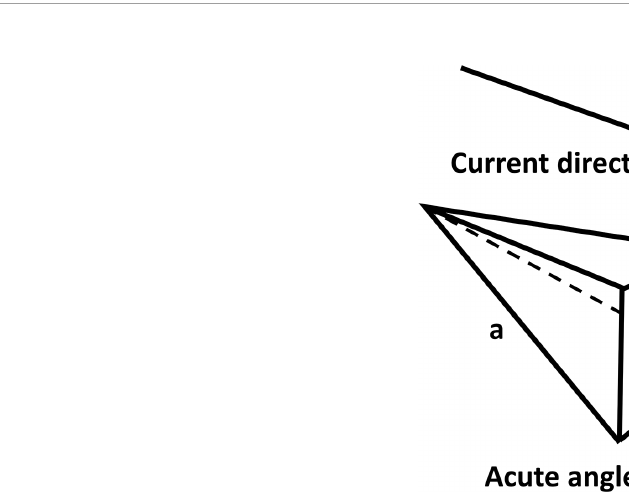
FIGURE 3 Schematic representation of ACN migration in seawater. (adopted from IMO/UNEP,